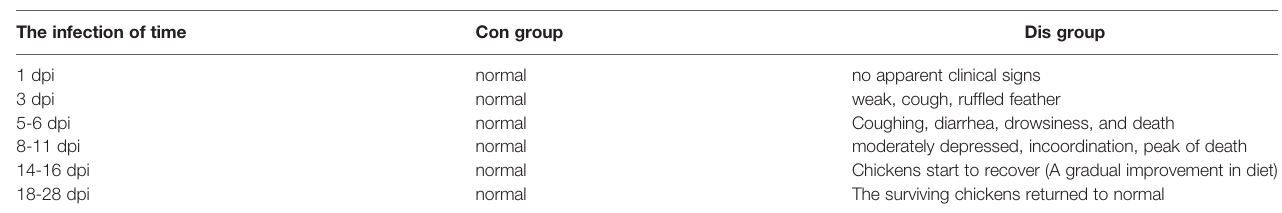
TABLE 2 | Clinical symptoms of control and diseased chickens infected with NIBV SX9. The infection of